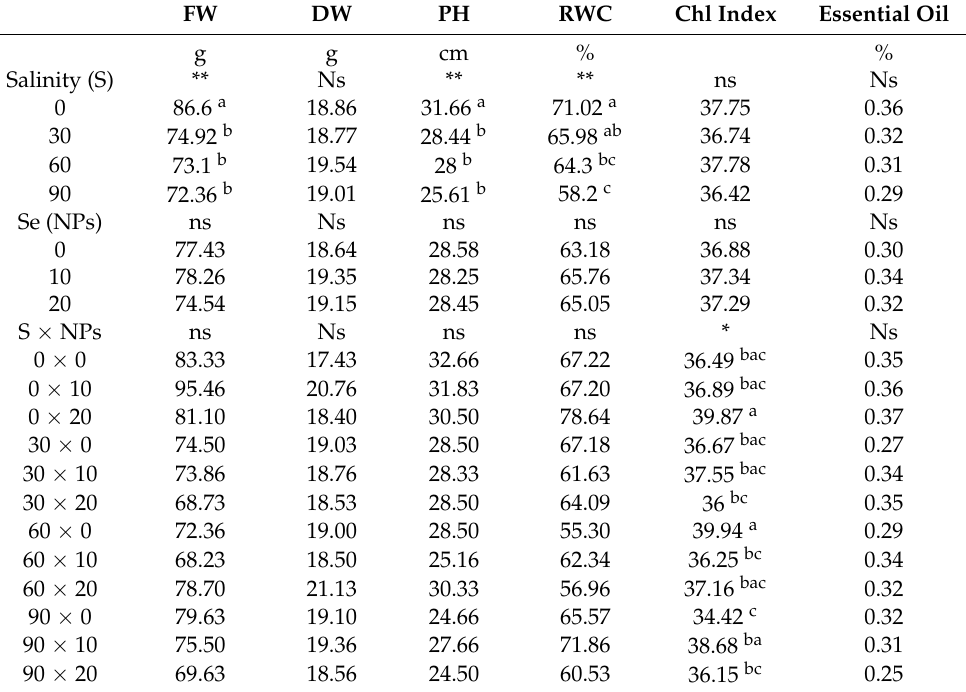
Table 1. Effects of foliar application of Se-NPs on the growth parameters and essential oil content of pineapple mint plants under different salinity stress.